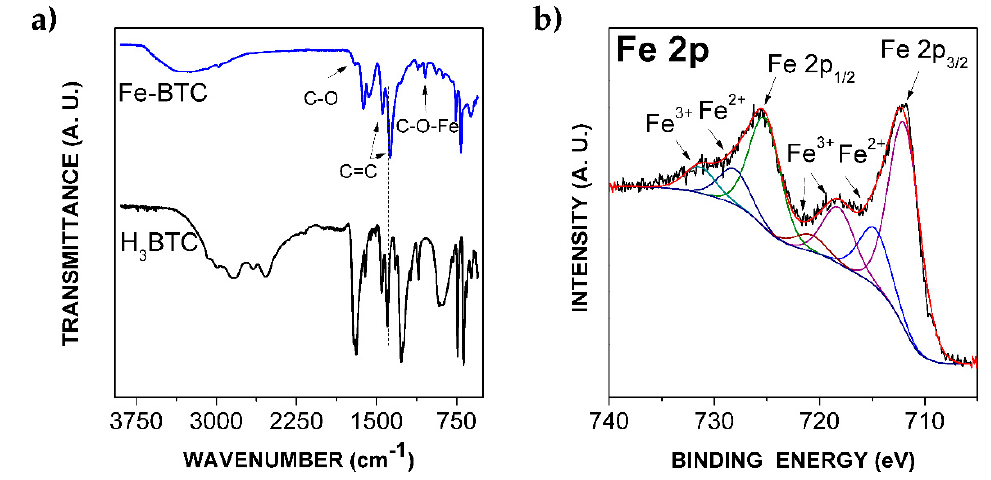
Figure 2. ( a ) FTIR spectra of the precursor H 3 BTC and synthetized Fe-BTC; ( b ) XPS spectrum and deconvolution of Fe 2p peaks of the Fe-BTC.